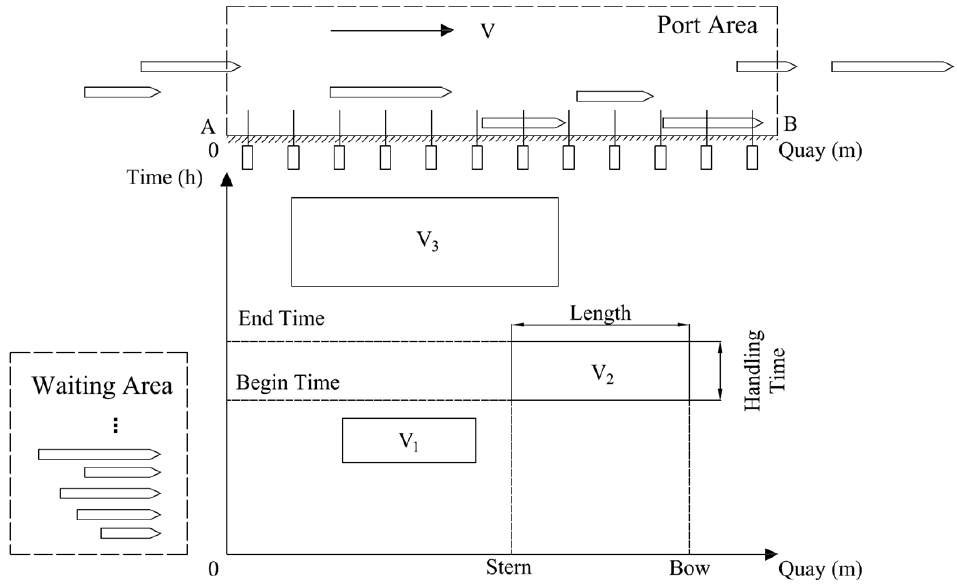
Figure 1. Two-dimensional diagram of integrated BACAP for continuous berth layout.